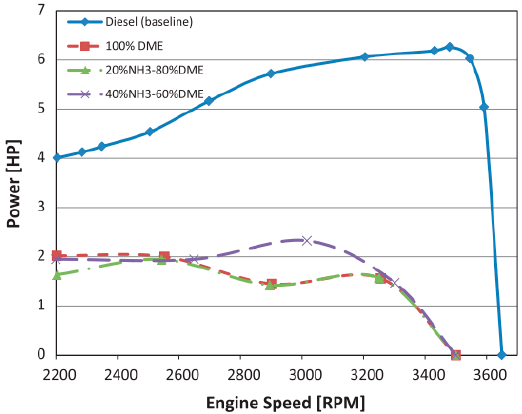
Figure 11. Range of different test conditions.